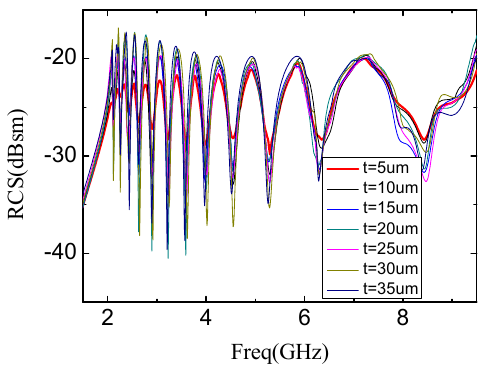
Figure 7. RCS results of Rectangular Slot Rings with different thicknesses of silver nanoparticle conductive ink layer.